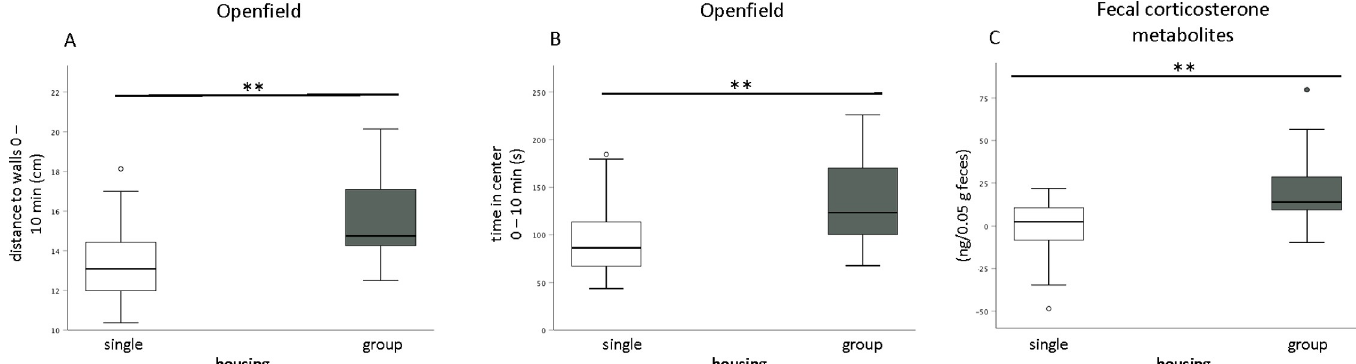
Fig 4. Housing effects. A-B) Open field, (n = 36, 18/group). Behavior of C57BL/6N mice in the OF. Group-housed mice stayed more distant to the walls (A), consequently they spent more time in the center (B). C) Fecal corticosterone metabolites (FCM), week 7–3, (n = 36, 18/group). Group-housed mice had higher FCM levels ( �� p = 0.002). Asterisks indicate the level of significance ( � p � 0.05; �� p � 0.01; ��� p �